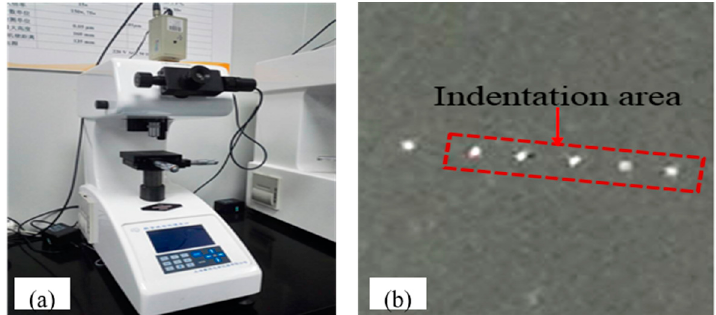
Figure 3. Indentation experiments: ( a ) experiment setup (HXD-2000TM /LCD microhardness tester); ( b ) specimens after indentation experiments.